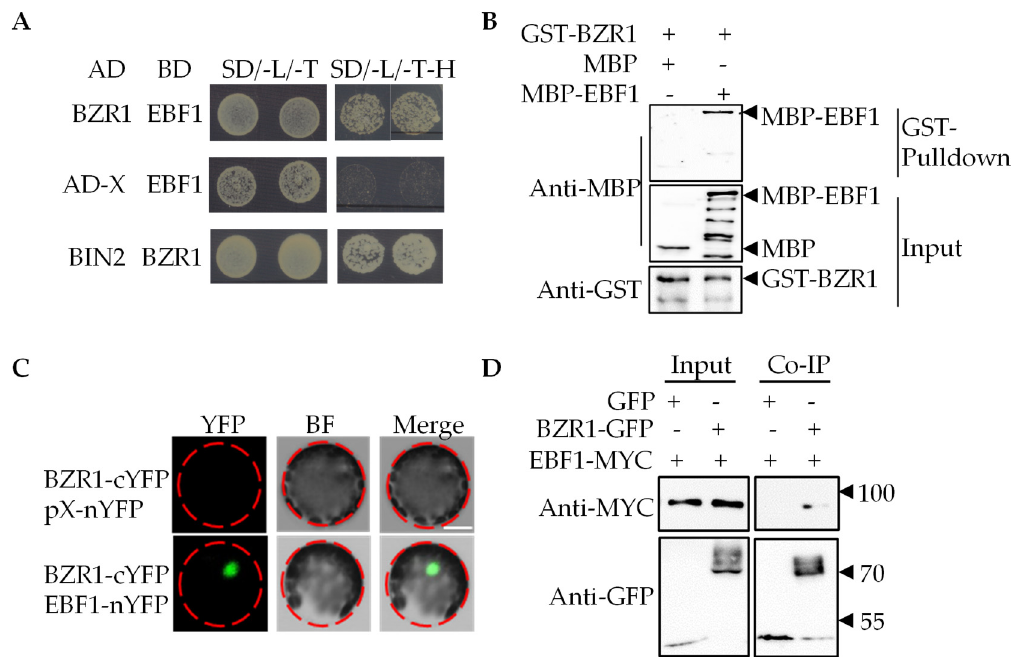
Figure 2. EBF1 interacted with BZR1. ( A ) The yeast two-hybrid assay showed that BZR1 interacted with EBF1 in yeast. ( B ) BZR1 directly interacted with EBF1 in vitro. Glutathione agarose beads loaded with GST-BZR1 were incubated with equal amounts of MBP or MBP-EBF1. Proteins bound to GST-EBF1 were detected by immunoblot analysis with an anti-GST antibody. ( C ) Confocal images of BiFC assays showed that BZR1 interacted with EBF1 in Arabidopsis mesophyll protoplast cells. Scale bar: 20 µm. ( D ) BZR1 interacted with EBF1 in vivo. Immunoprecipitation was performed using GFP-trap beads and Arabidopsis mesophyll protoplasts co-expressing pro35S:EBF1-MYC and pro35S:GFP or co-expressing pro35S:EBF1-MYC and pro35S:BZR1-GFP . The immunoblots were probed with anti-MYC or anti-GFP antibodies.